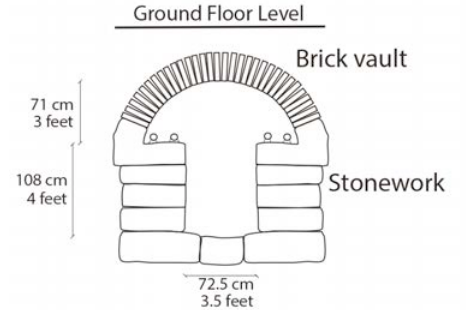
Figure 3. Section of the water supply tunnels inside the Monastery. Depth from the ground floor level varies from 0.5 m to 1